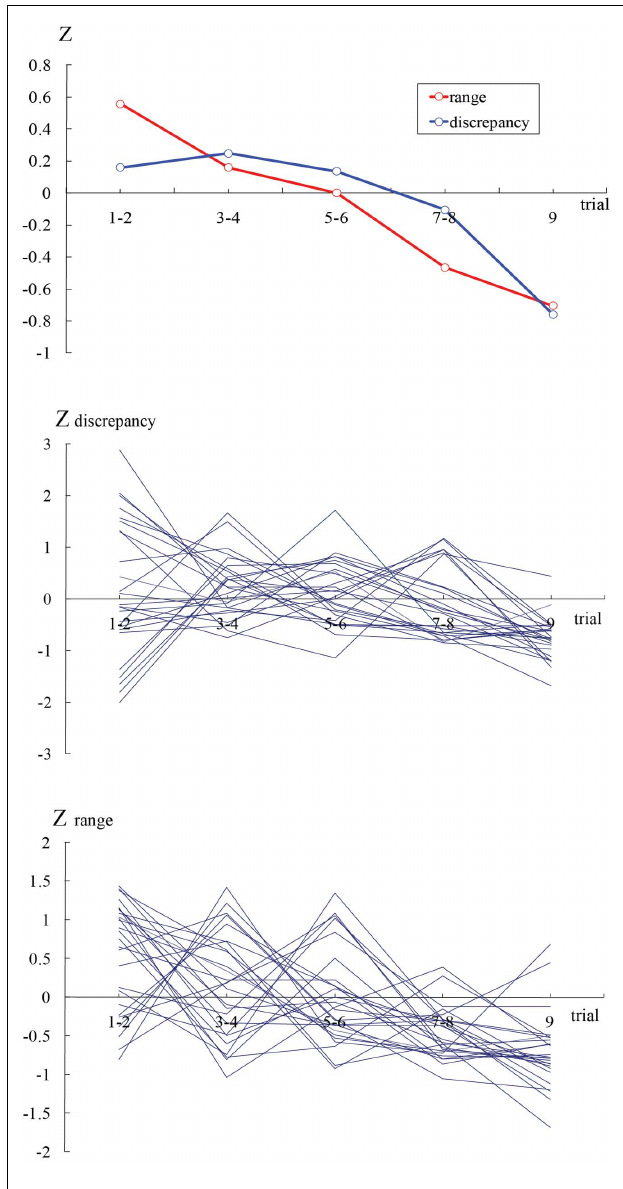
FIGURE 2 |The standardized discrepancy and range (adjusted for the number of foods) measures as a function of training trials. Top: means of the standardized discrepancy and range plotted against training trials. Middle: overlaid z scores for the range measures of individual participants plotted against training trials. Bottom: overlaid z scores for the discrepancy measures of individual participants plotted against training trials.